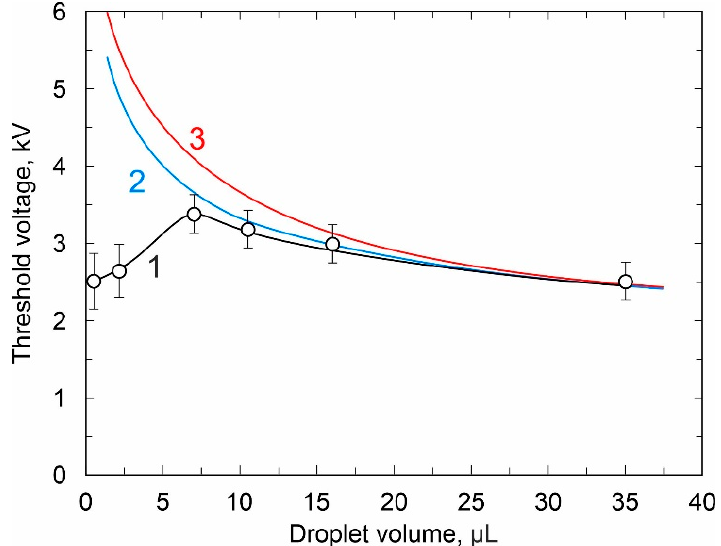
Figure 2. The dependence of threshold voltages on the droplet volume; 1—experimental data, 2—analytical calculations, 3—corrected analytical dependence.